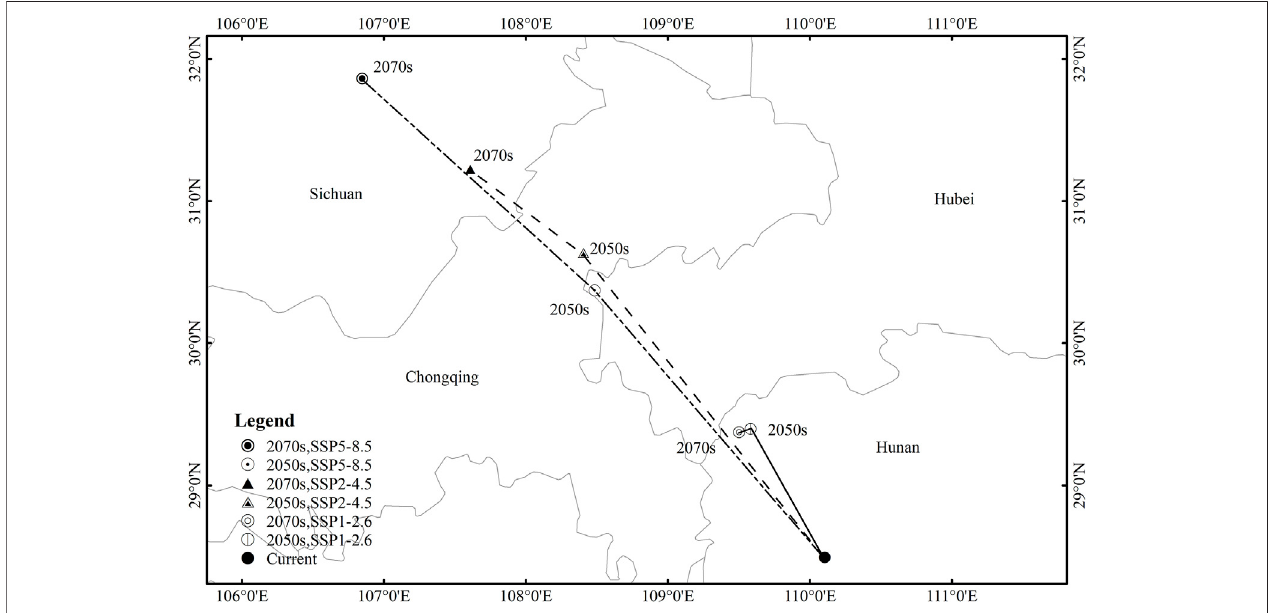
FIGURE 5 | Shifts in the centroid area distributions for Cremastra appendiculata highly suitable area under different scenarios of climate change.